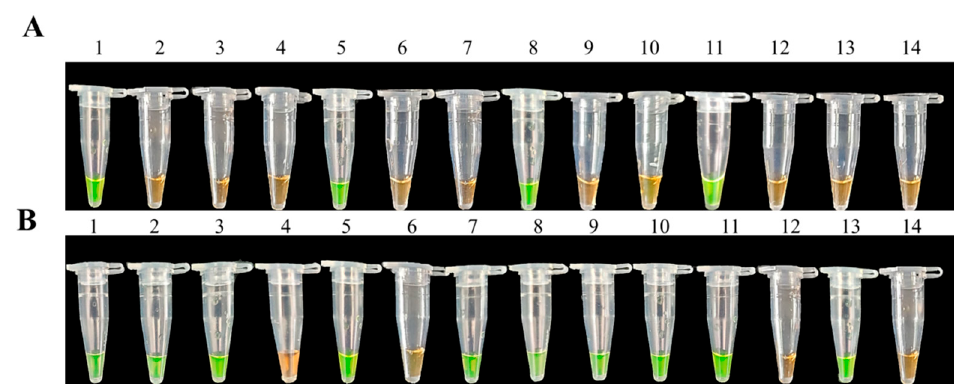
Figure 8. LAMP assay random sampling detection of F. oxysporum in potted plants of D. officinale before pesticide control. ( A ) = LAMP assay to detect F. oxysporum in potted plants of D. officinale from random samples before the symptoms of soft rot were exposed in pots: 1, purified genomic DNA of F. oxysporum (positive control); 2–13, DNA from D. officinale stems before the symptoms of soft rot were exposed in pots; 11, DNA from healthy D. officinale stems (negative control); ( B ) = LAMP assay to detect F. oxysporum in potted plants of D. officinale from random samples after the symptoms of soft rot were exposed in pots: 1, purified genomic DNA of F. oxysporum (positive control); 2–13, DNA from D. officinale stems after the symptoms of soft rot were exposed in pots; 11, DNA from healthy D. officinale stems (negative control). Table 3. Effect of fungicide synergism combinations against soft rot in D. officinale .